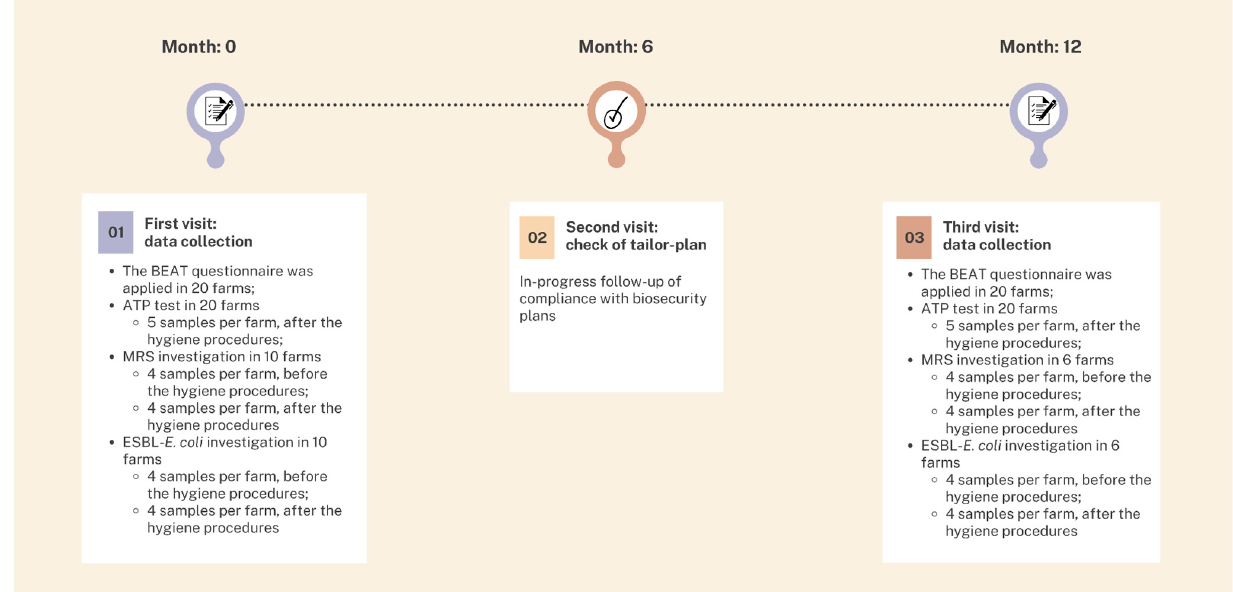
Figure 1. Timeline of the data collection over the 12-month period of the study. BEAT: Biosecurity Risk Analysis Tool; ATP: adenosine triphosphate; MRS: methicillin-resistant staphylococci; ESBL- E. coli : extended-spectrum β -lactamase producing Escherichia coli .